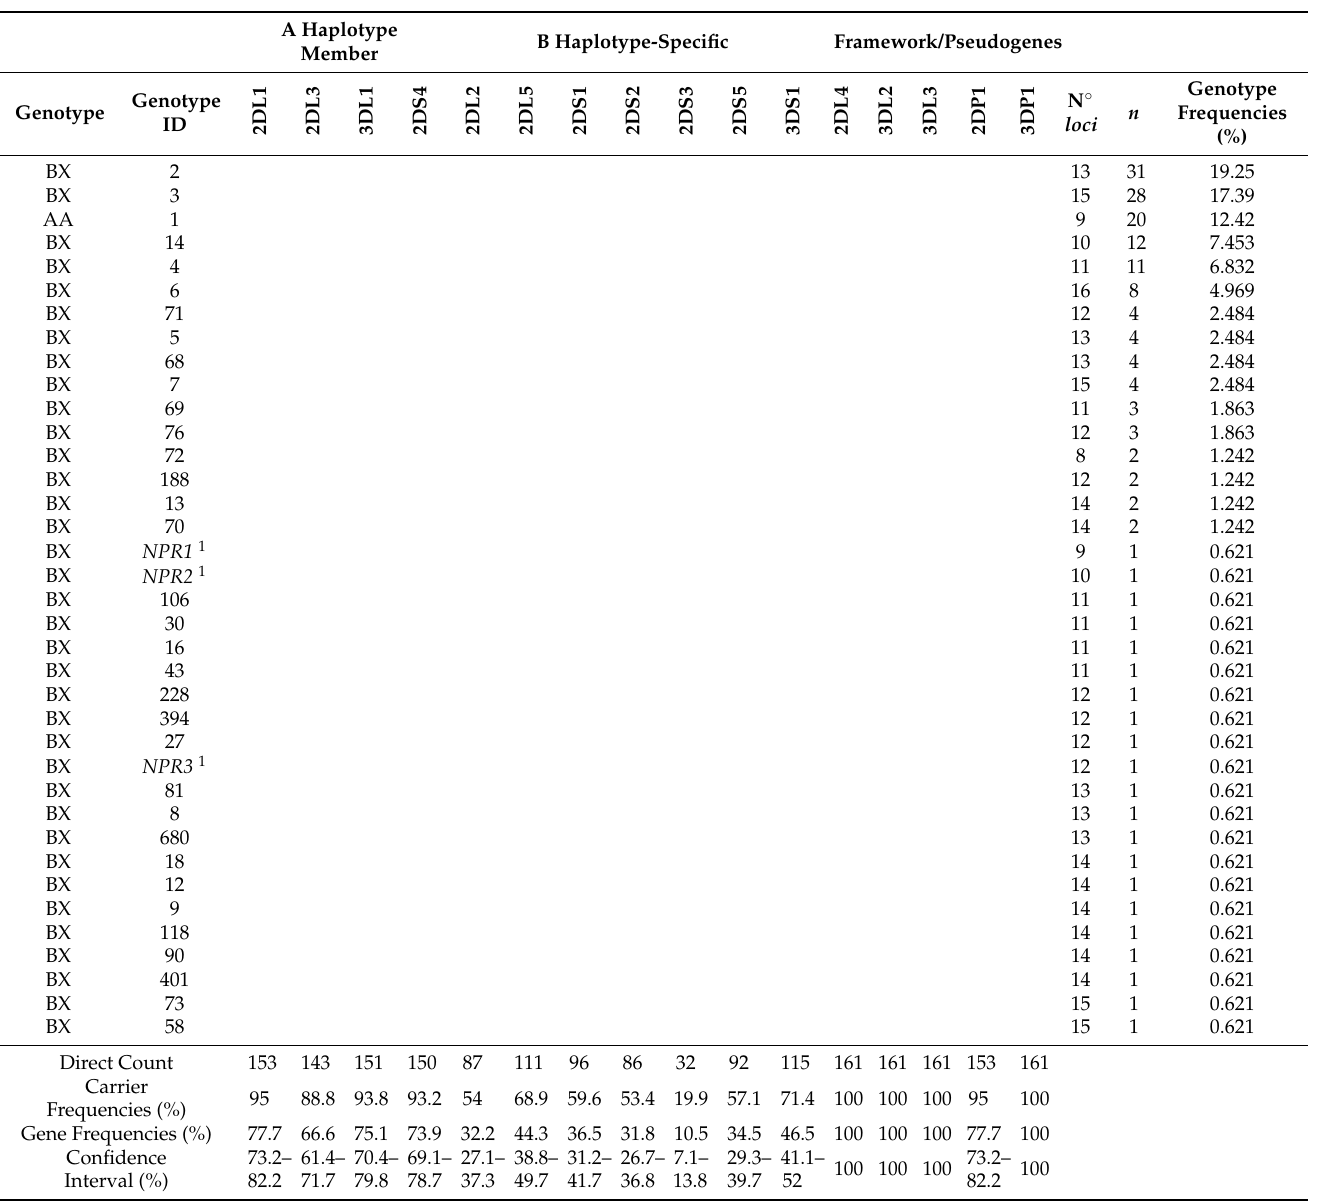
Table 1. KIR gene and genotype